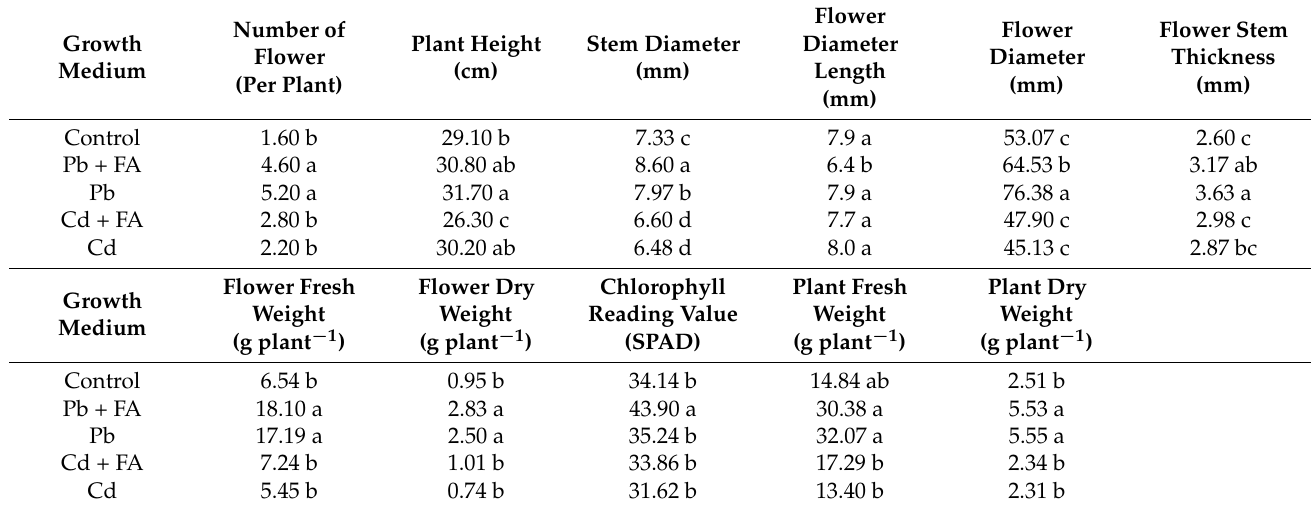
Table 1. Effect of different growing medium on growth parameters of Tagetes eracta .